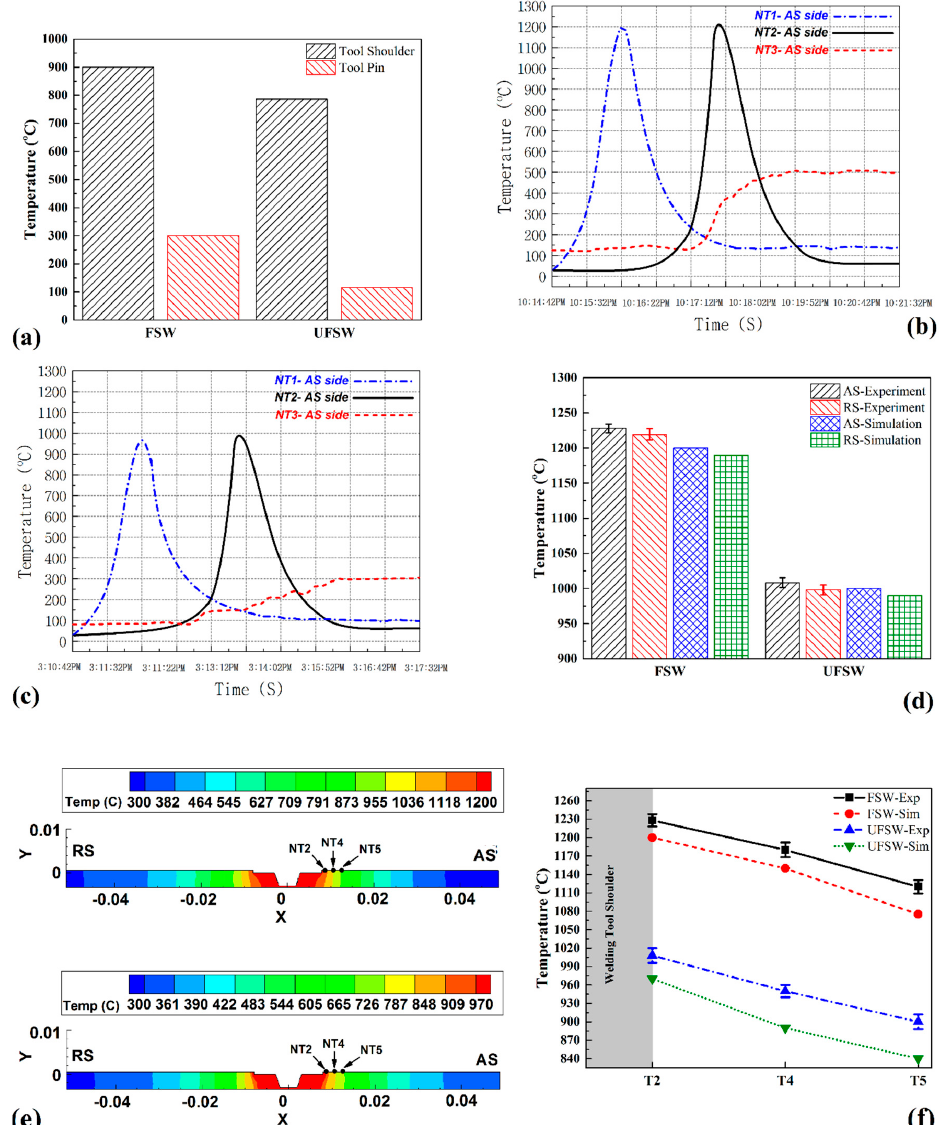
Figure 3. ( a ) Comparison of heat generation rate by different area of tool. Thermal history of ( b ) FSW and ( c ) UFSW samples. ( d ) Comparison of maximum recorded and simulated heat at RS and AS. ( e ) Simulation results of internal heat flow. ( f ) Comparison between recorded and simulated results of cooling rate.